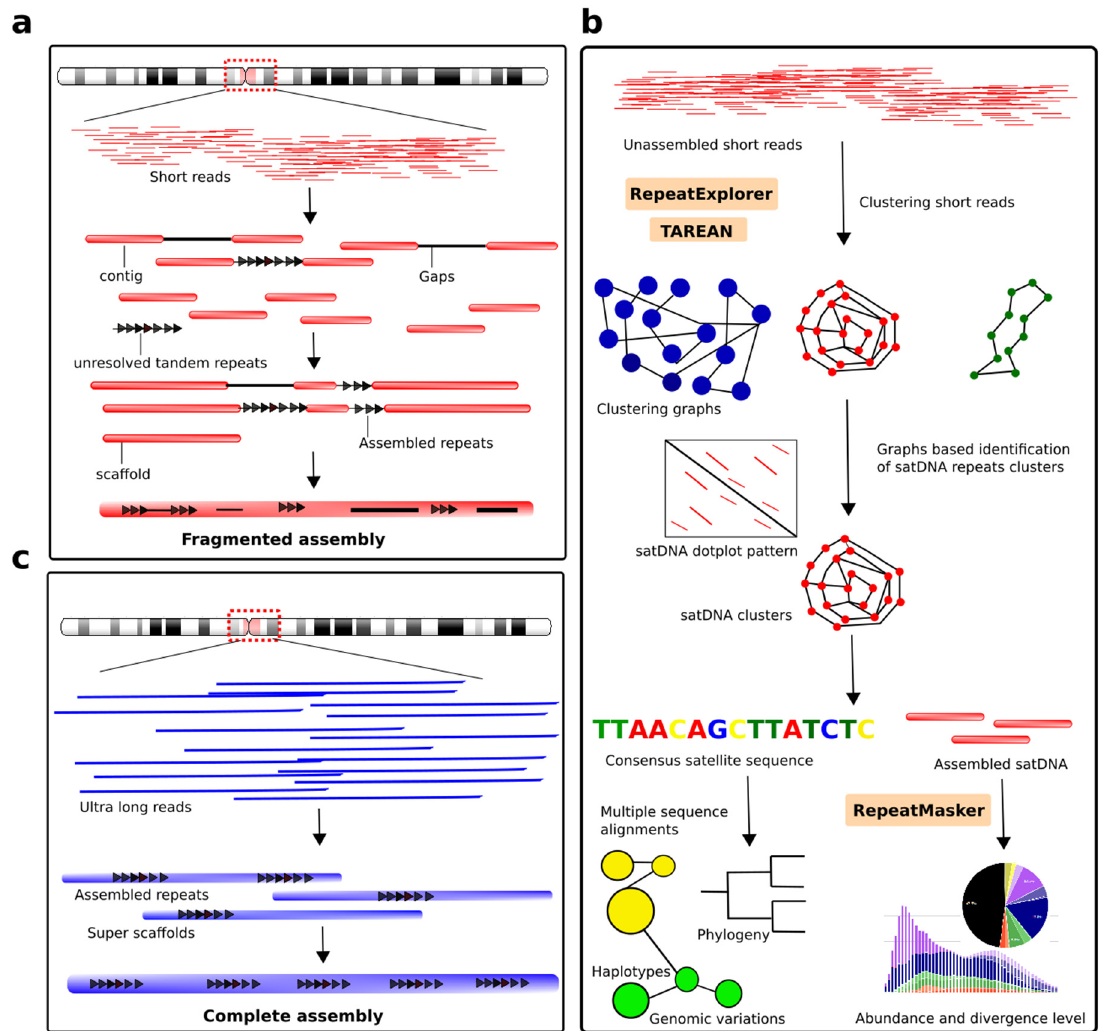
Figure 6. Schematic illustration of genome assembly limitations and new next-generation sequencing approaches for satellite DNA analysis. ( a ) Centromere region of the human chromosome that could not be assembled using short-read sequencing and is not represented in primary human assemblies. The assembly algorithms cannot be used for short reads (red lines) of the centromere owing to high-level reiteration of tandem repeats (black triangles) and therefore could not be recovered in the assembly. The fragmented assembly may contain gaps, thereby missing satellite DNA sequences causing bias to genome annotation. ( b ) A cheap alternative to analyze the satellite directly is the development of clustering-based pipelines, which can graphically predict different repeats and cluster them into groups. These programs yield assembled contigs, which can be further utilized for downstream analyses, such as repeats abundance, divergence, and comparative genomic analysis. ( c ) Recent developments (ultra-long-read technology) have successfully recovered the complete human genome assembly [279].